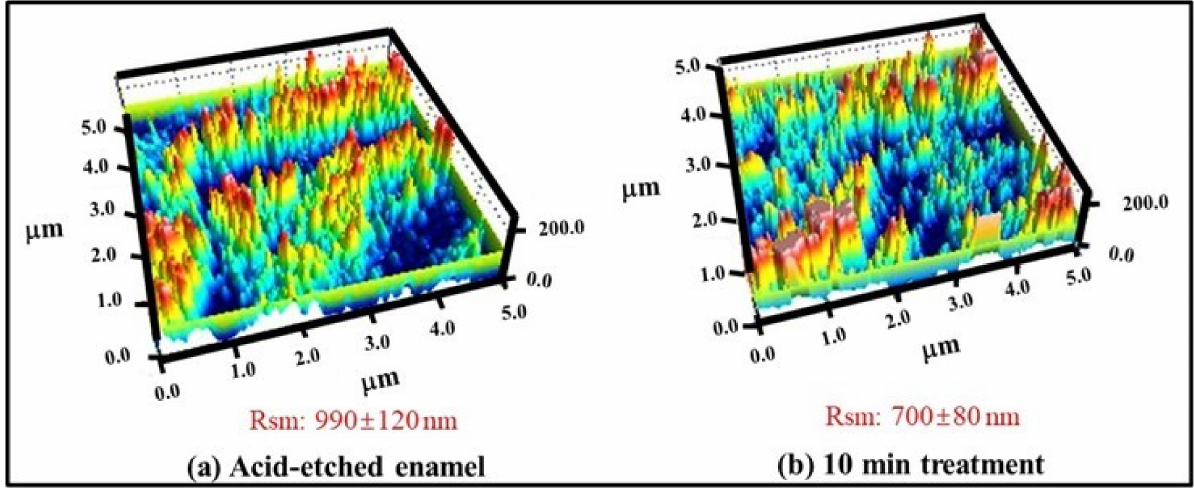
Figure 2. The representative 3-D plots of surface topology and spacing parameters (Rsm) for ( a ) acid-etched enamel surface and ( b ) after 10 min remineralization